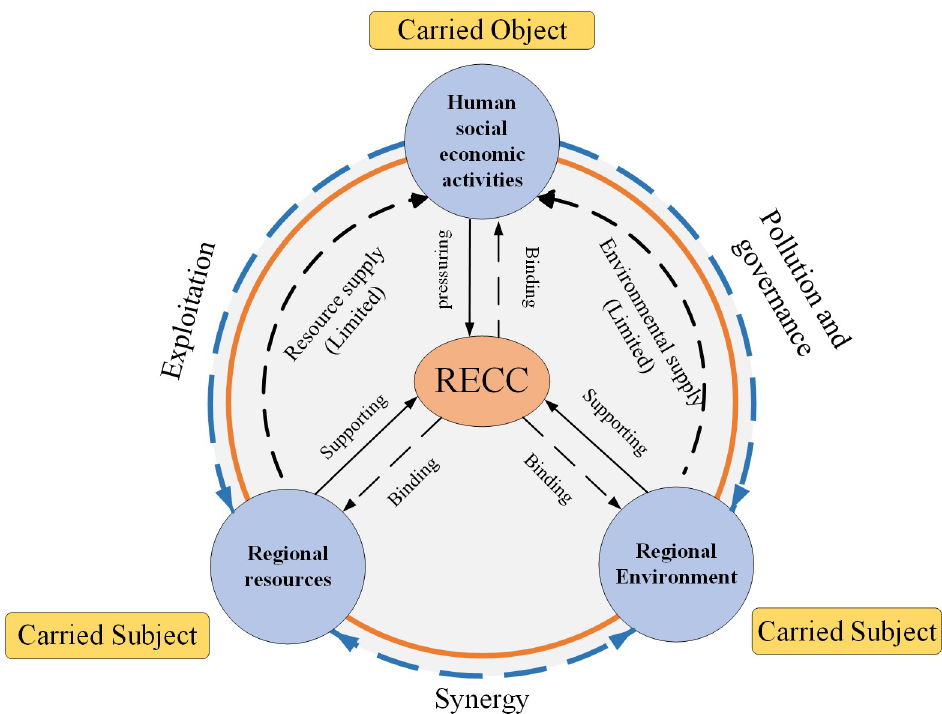
Fig 1. Interaction between the influencing factors of resource and environmental carrying capacity.